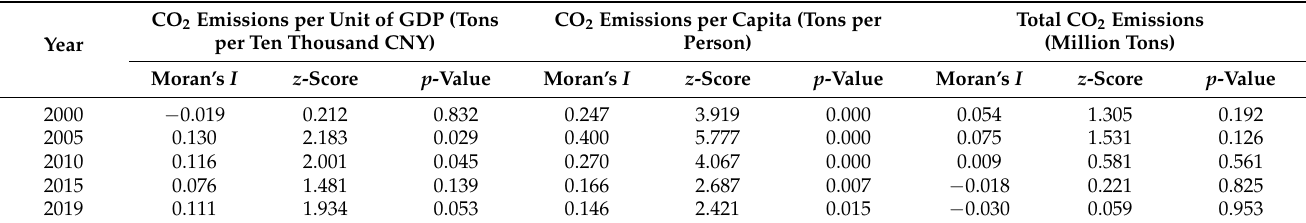
Figure 9. Spatiotemporal distribution of provincial-level CO 2 emissions per unit of GDP (in tons · CNY 10,000 − 1 ) in China (five-time sections). Table 1. Spatial autocorrelation indicators of carbon emissions in China from 2000 to